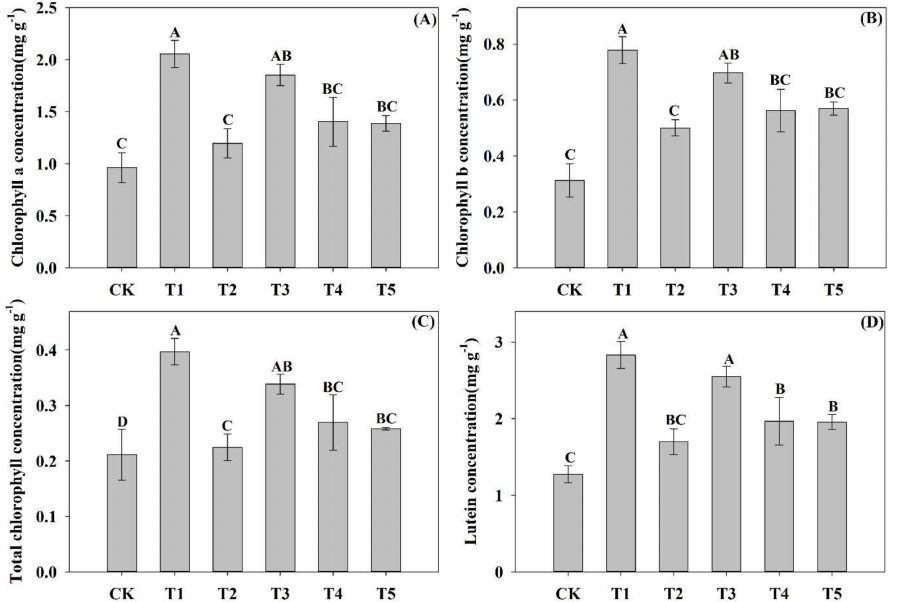
Figure 2. Differences of chlorophyll a, chlorophyll b, total chlorophyll, and lutein concentra- tion of pecan seedlings under varying NH 4+ :NO 3 − ratios. Chlorophyll a concentration of pecan seedlings under varying NH 4+ :NO 3 − ratios ( A ). Chlorophyll b concentration of pecan seedlings under varying NH 4+ :NO 3 − ratios ( B ). Total chlorophyll concentration of pecan seedlings under varying NH 4+ :NO 3 − ratios ( C ). Lutein concentration of pecan seedlings under varying NH 4+ :NO 3 − ratios ( D ). Uppercase letters indicate differences between NH 4+ :NO 3 − ratio treatments, at p <